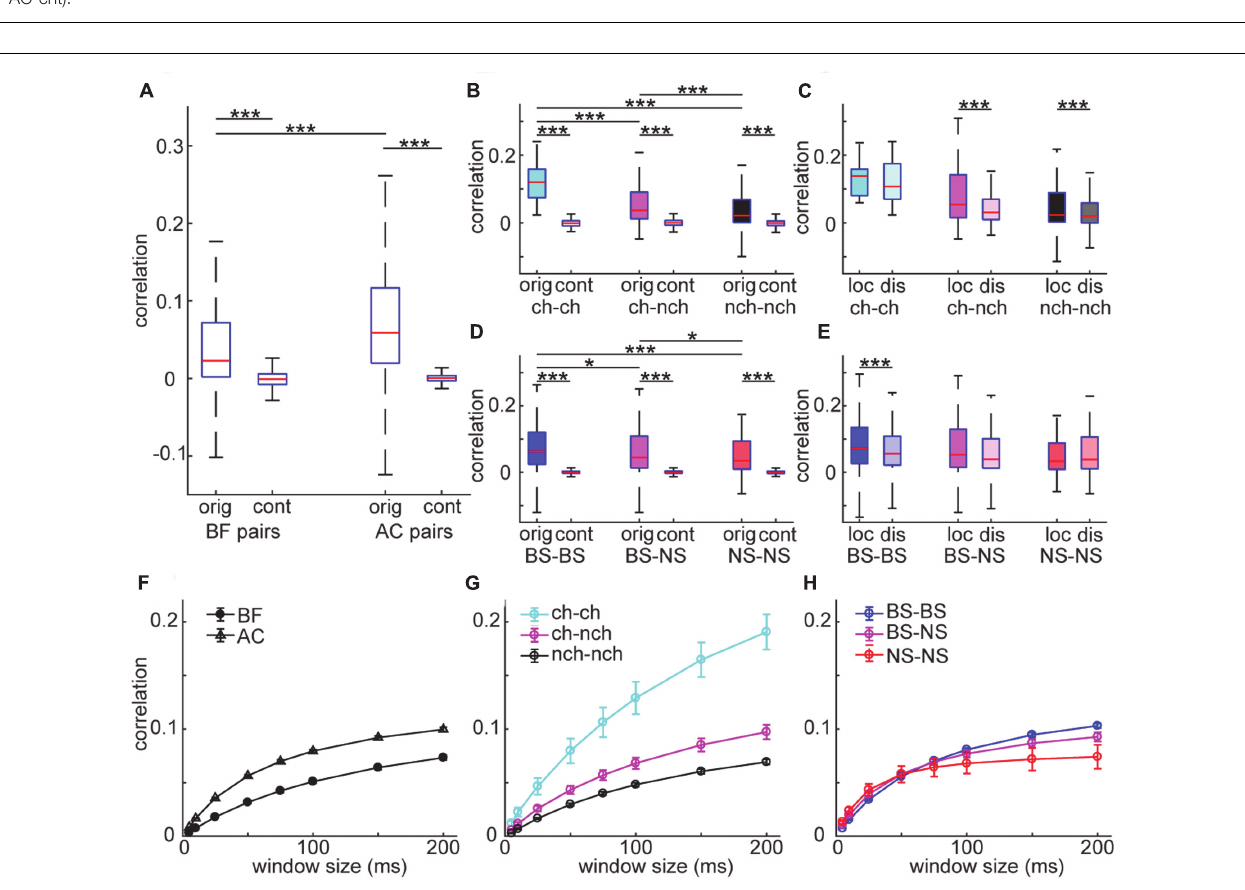
FIGURE 5 | Spike count noise correlations in BF and AC neuron pairs. (A) Comparison of correlations between BF and AC pairs. As a control (cont), surrogate data was generated by using the raster marginals model. The effect of pair was highly significant ( F 3 , 74455 = 1148, p < 0.00001, one-way ANOVA). ∗∗∗ p < 0.00001 (